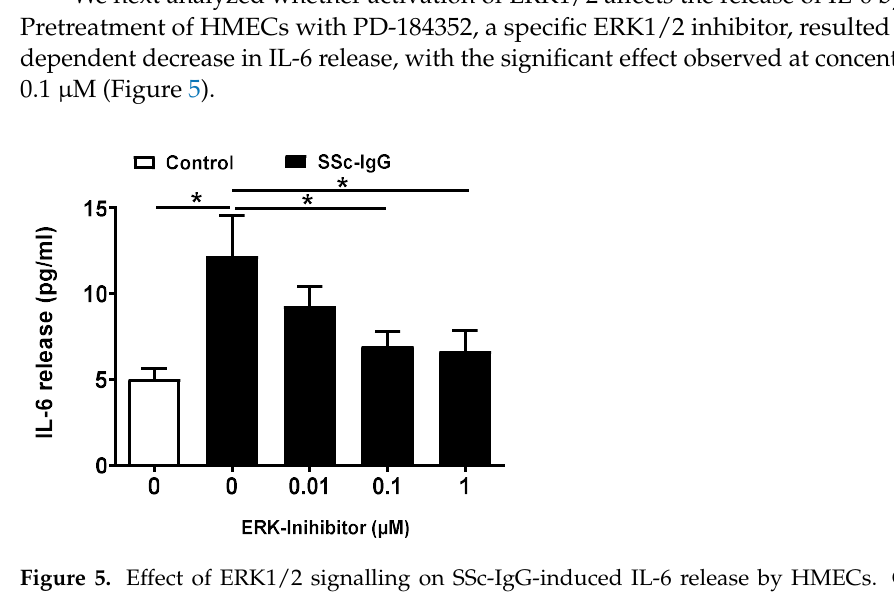
Figure 5. Effect of ERK1/2 signalling on SSc-IgG-induced IL-6 release by HMECs. Cells were pretreated with or without the specific ERK 1/2 inhibitor PD-184352 for 1 h, then stimulated with mean +/− SEM with * p < 0.05.